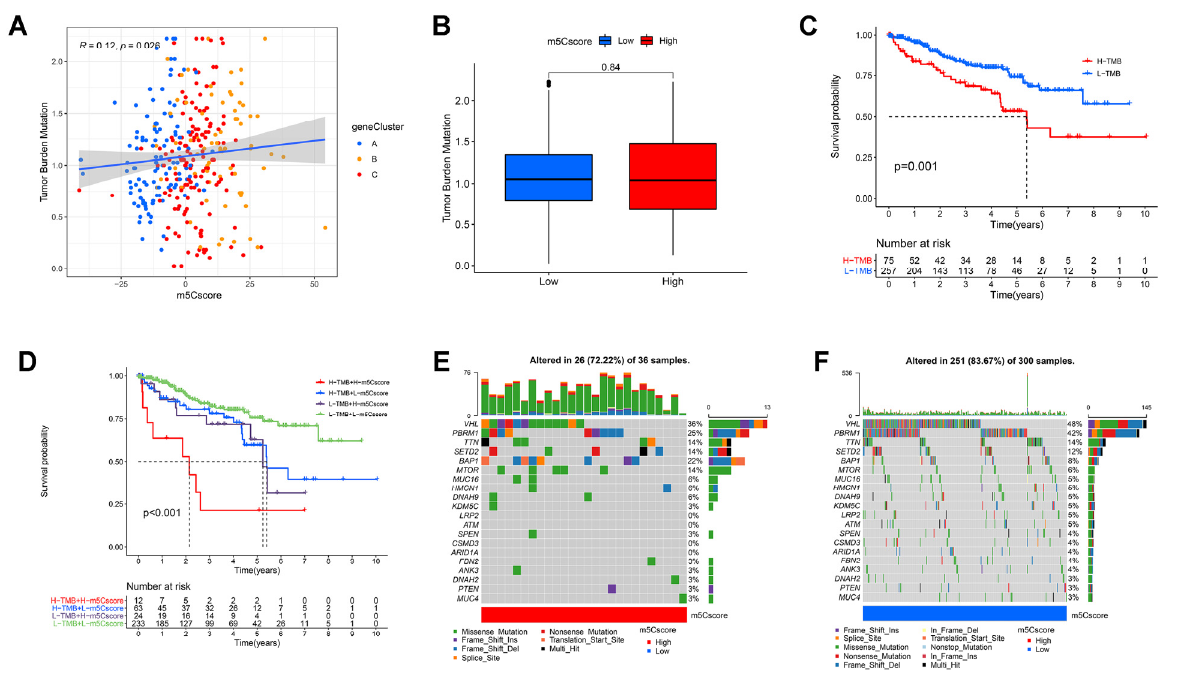
Figure 6. Correlation between m5Cscore and somatic variants. ( A ) Scatterplots depicting positive correlation between m5Cscore and TMB. ( B ) TMB difference in high- and low-m5Cscore subgroups (Wilcoxon test). ( C ) Kaplan-Meier curves for high- and low-TMB groups of ccRCC patients. ( D ) Kaplan–Meier curves for patients stratified by both TMB and ICI scores. ( E , F ) oncoPrint was constructed using high m5Cscores on left ( E ) and low m5Cscores on right ( F ).